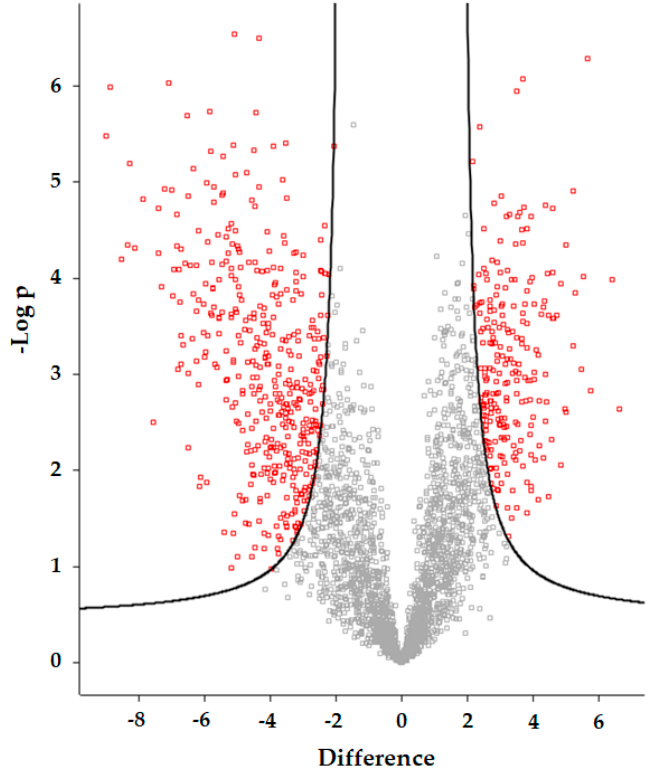
Figure 4. Volcano plot analysis of the differences in the identified protein groups between the PGC and SAX fractionated samples. Protein groups were filtrated using the following parameters: minimal valid values: 3 ; mode: in at least one group. As a statistical test, a t- test with FDR = 0.01 and s0 = 2 was used. The red squares represent the protein groups whose intensities were >2-fold changed, compared to the intensity of the protein group identified by PGC and SAX.